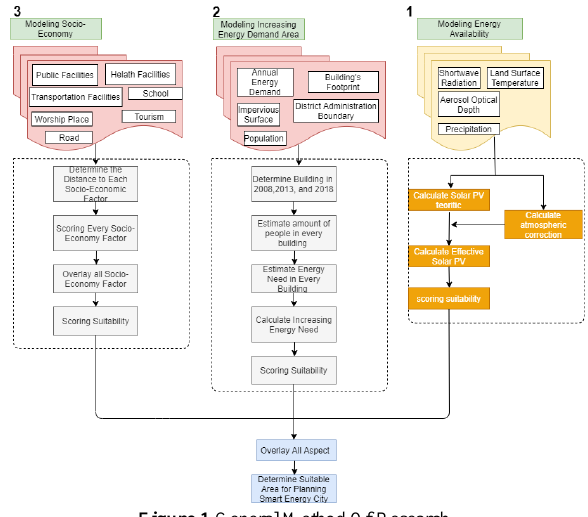
Figure 1 General Method Of Research 2.2.1 Modeling Energy